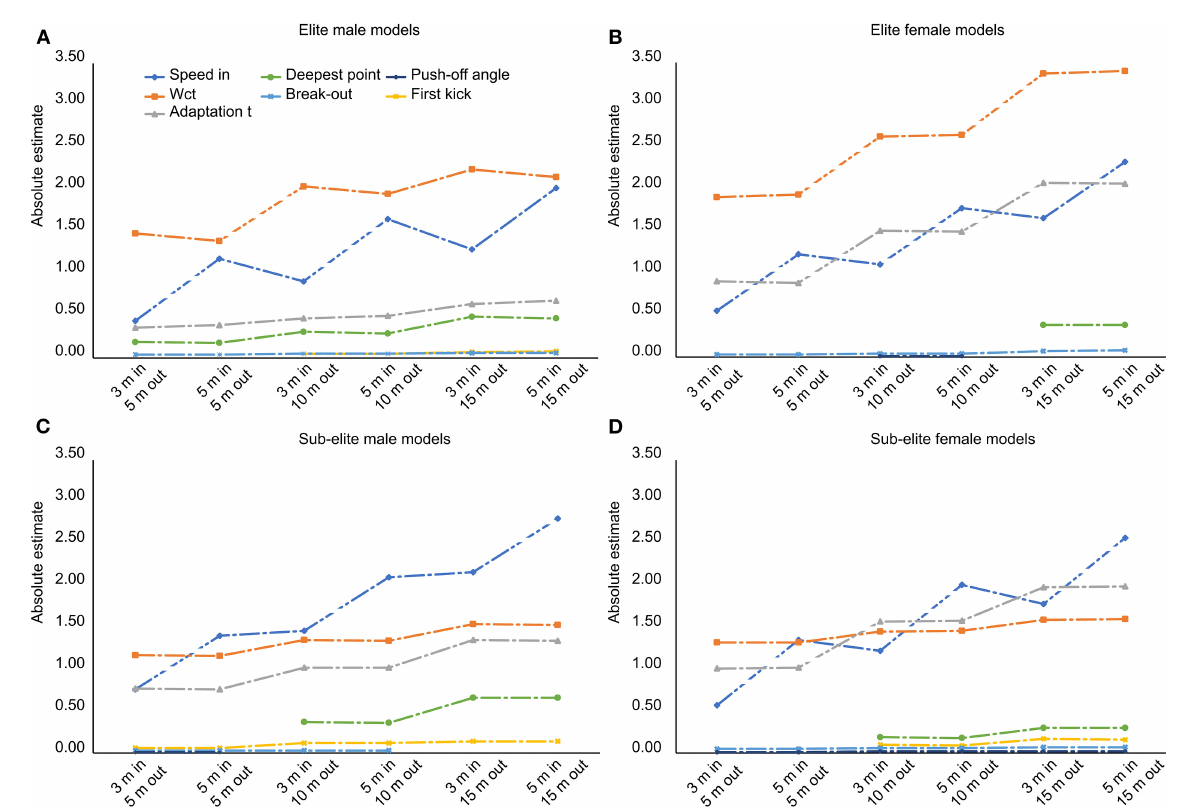
FIGURE3 (A–D) The absolute estimates of the seven contributors (speed-in, adaptation time, wall contact time (WCT), break-out distance, deepest point in the underwater phase, distance at first kick and push-off angle) to the elite male and female and sub-elite male and female models are presented graphically. The different models are presented on the x